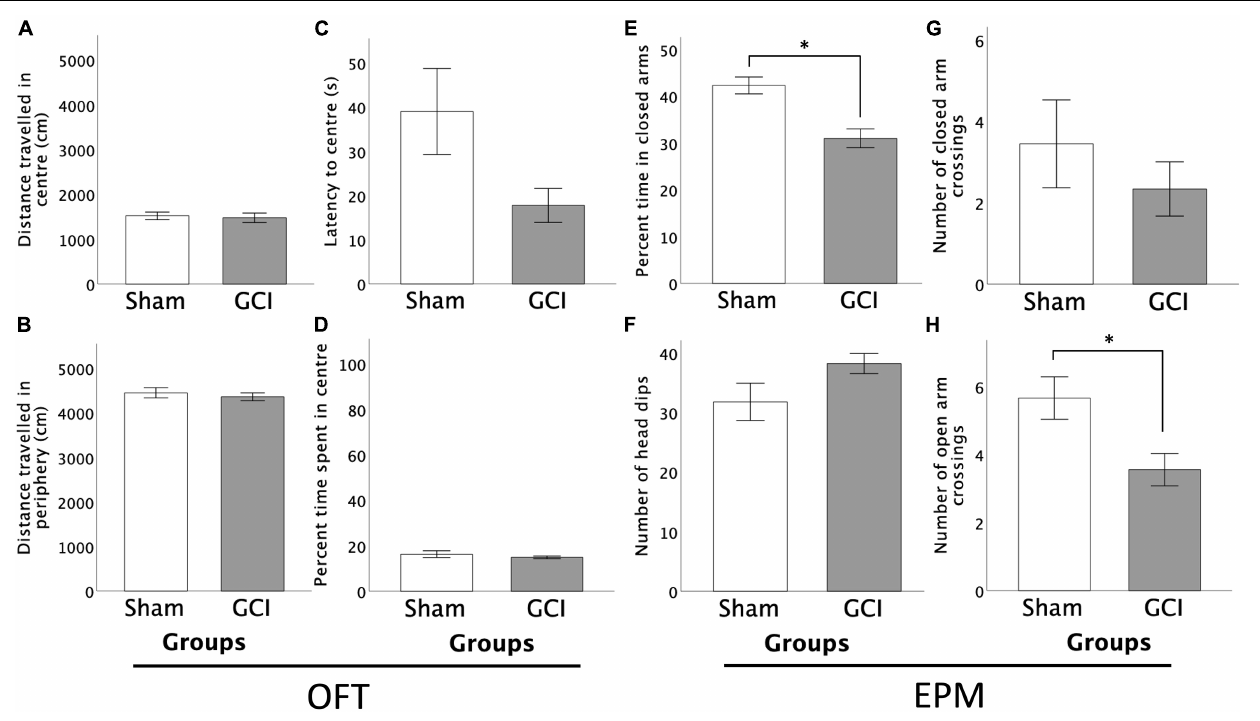
FIGURE 4 | Effects of GCI on OFT and EPM performance. Left side of figure shows distance travelled in the centre (A) and periphery (B) of the OFT, and latency to centre (C) and percentage of time spent in the centre zone (D) . Right side of figure shows percentage of time spent in the closed arms of the EPM (E) , number of head dips (F) , and number of closed (G) and open (H) arm crossings. Values are presented as mean ± S.E.M. ∗ Indicates statistical significance at p < 0.05. GCI, global cerebral